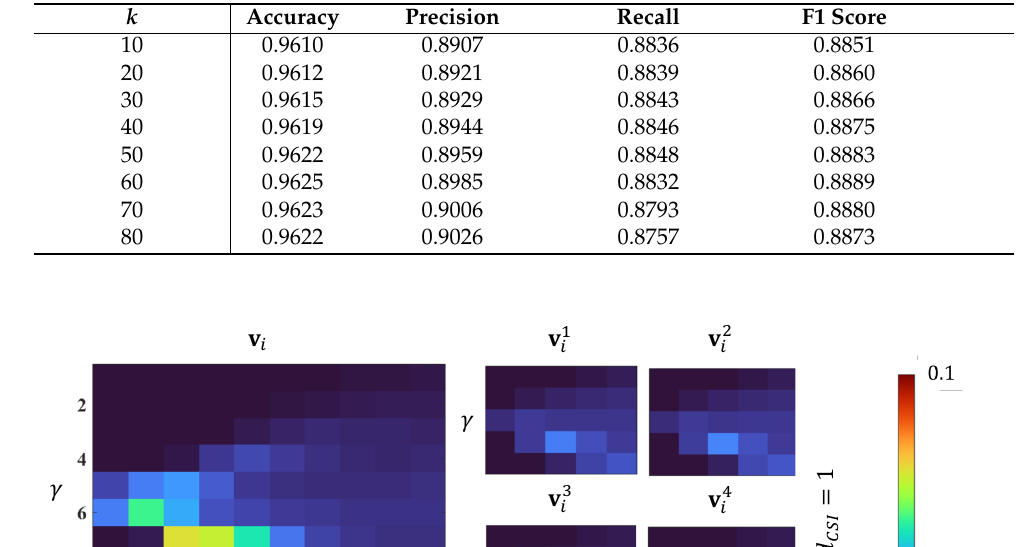
Table 2. Search for acceptable size of k .